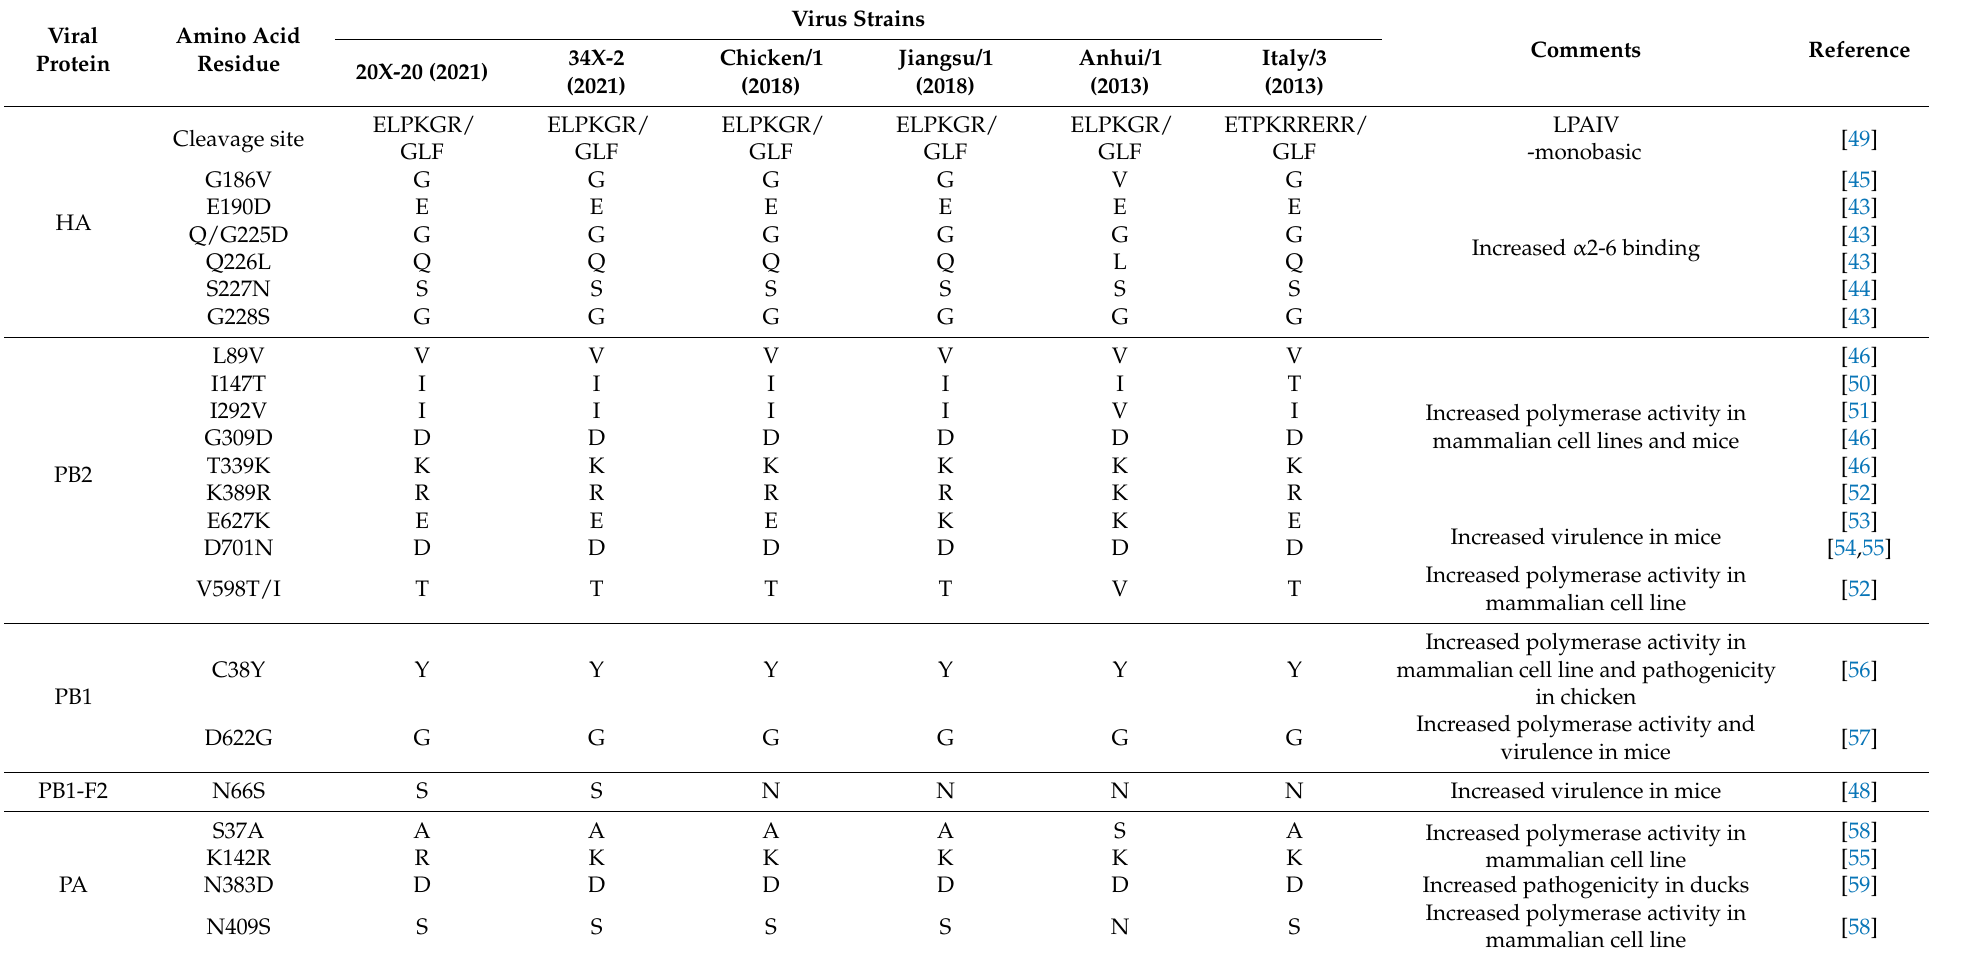
Table 1. Molecular characterization of H7 avian influenza virus (AIV)